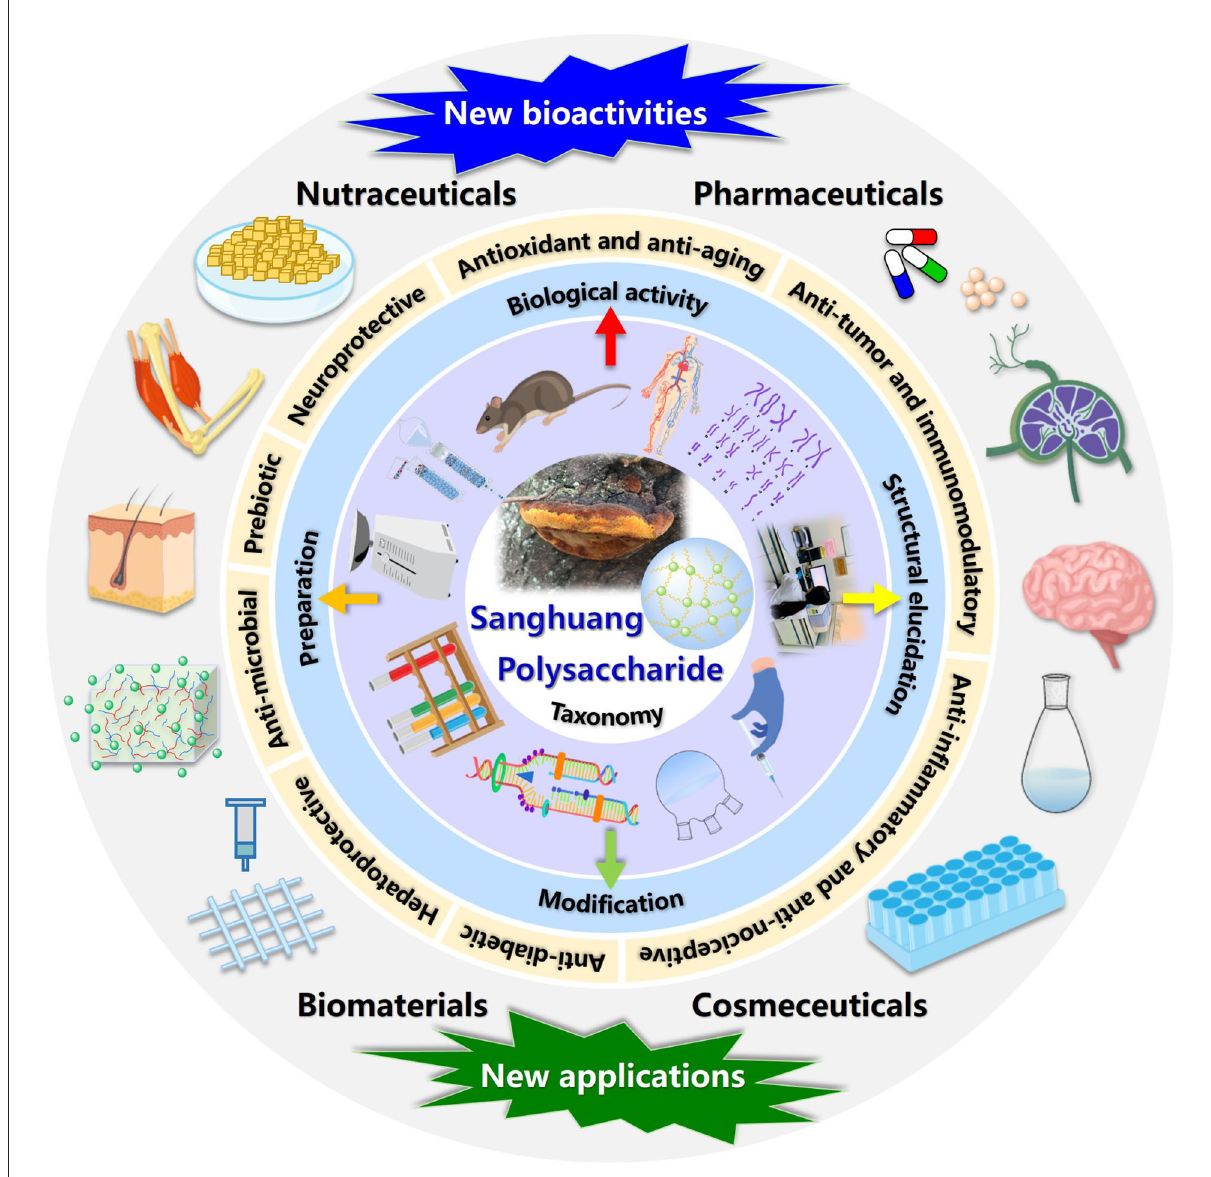
FIGURE2 The overall highlights discussed in this